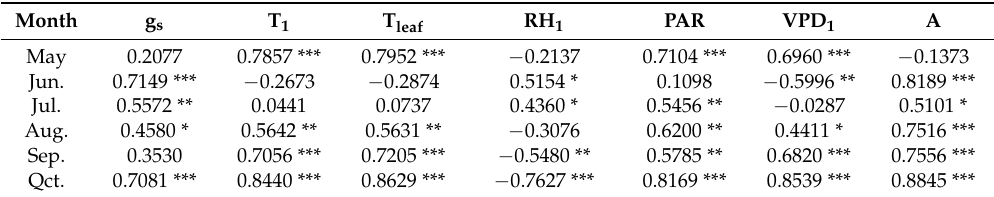
Table 2. Summary of correlations (Pearson) between the transpiration rates ( T r , mmol H 2 O m − 2 s − 1 ) of R. soongorica and other gas exchange parameters.